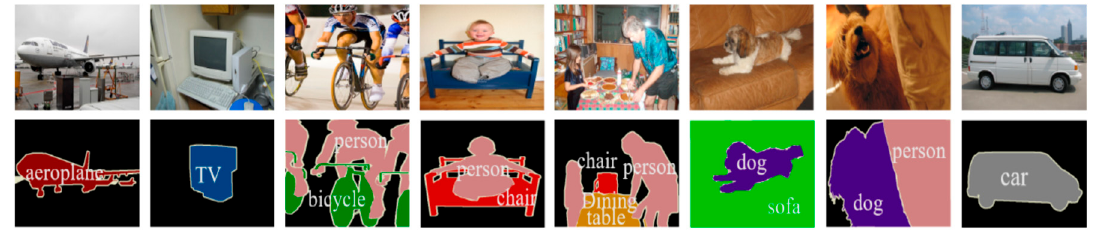
Figure 4. A set of images and their corresponding ground-truth annotations.